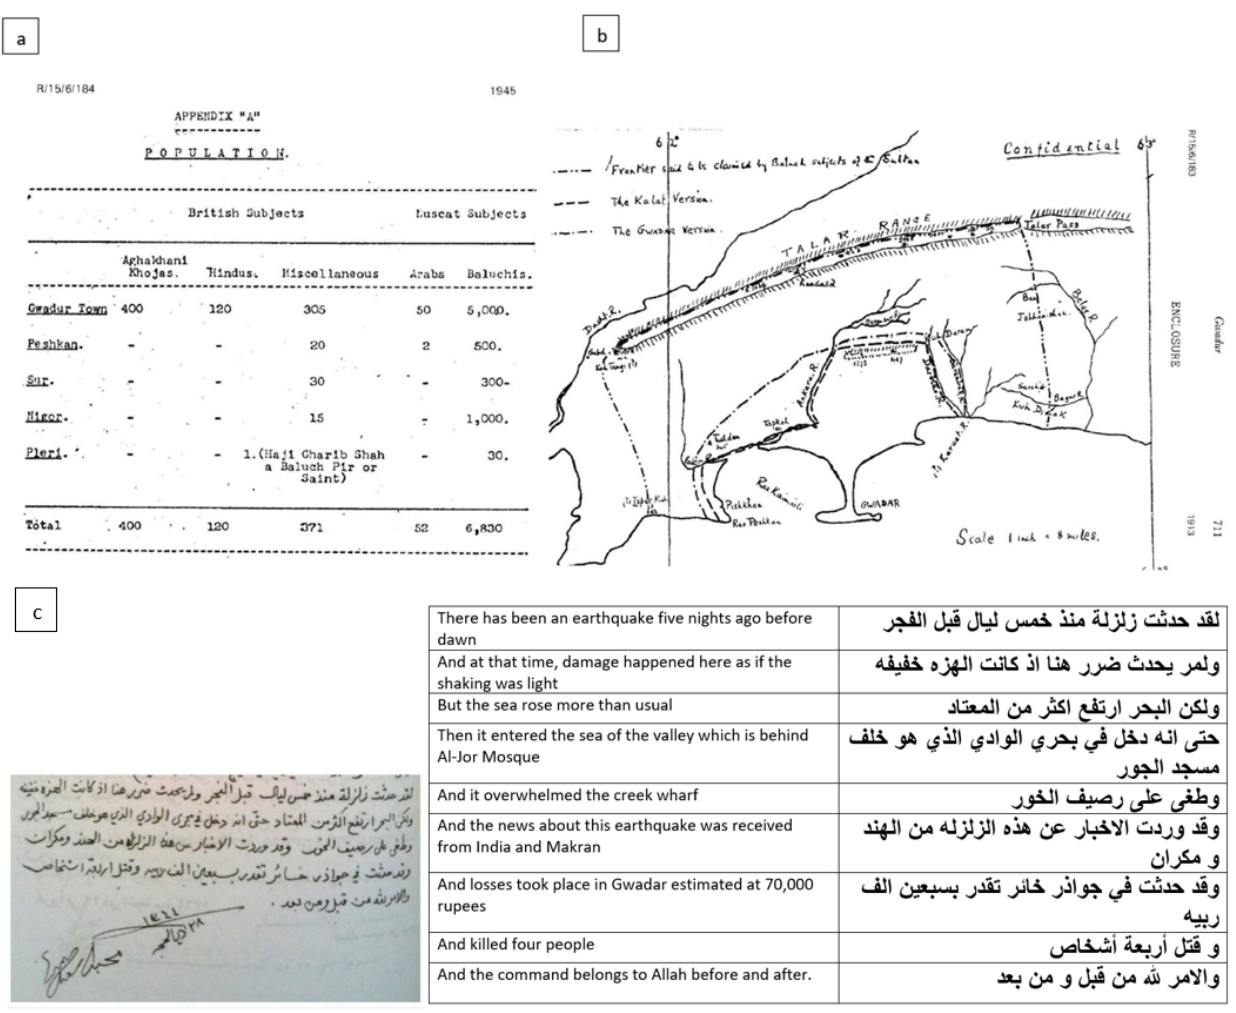
Figure 2. (a) Population of Gwadar in 1945 from Records of Oman 1867–1947 (Bailey, 1988). (b) Old map of Gwadar from a letter written by Lieut. Col. J. Ramsay, agent to the governor general and chief commissioner in Balochistan, to mark the boundary of Gwadar and Kalat in 1913, printed in Records of Oman 1867–1947 . (c) An excerpt of a letter by the Sultan of Oman, Said bin Taimur, along with a translation of the